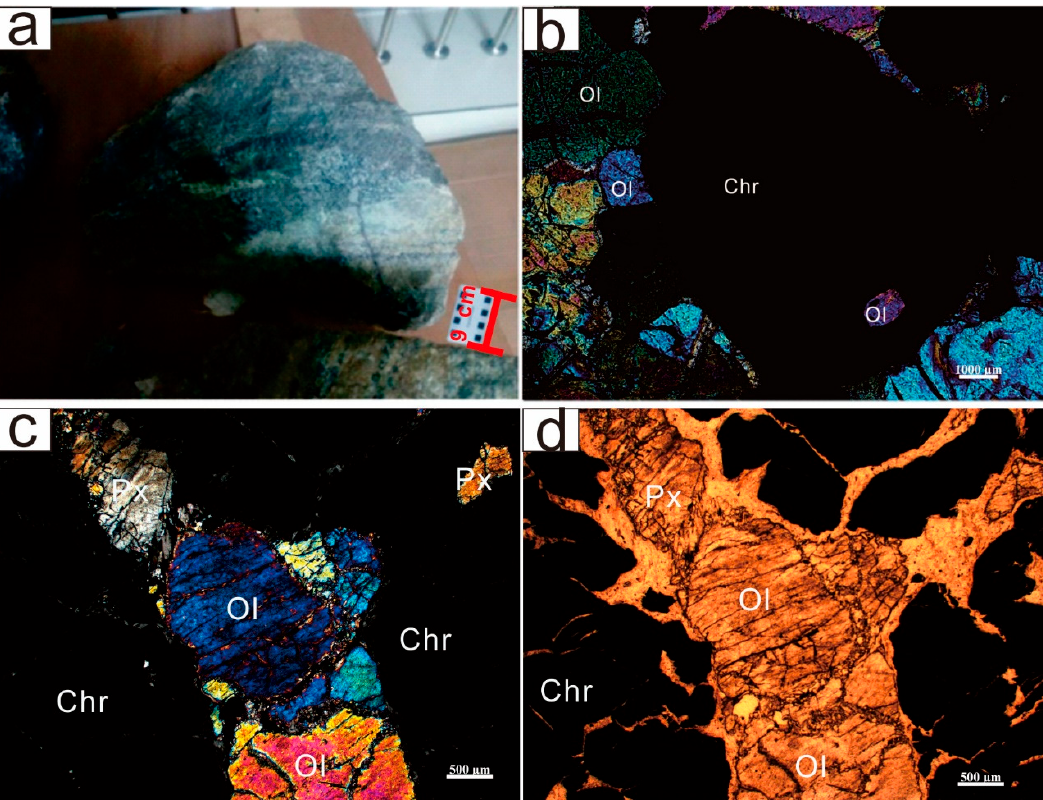
Figure 1. ( a ) Distribution map of the Transhimalayan batholith (modified after Ji et al. [18]); ( b ) Simplified geological map showing the location of the Jijal complex of the Kohistan island arc complex, northern Pakistan (after Burg et al. [1]); ( c ) Geological section of the Jijal mafic–ultramafic complex (modified after Burg et al. [21]).